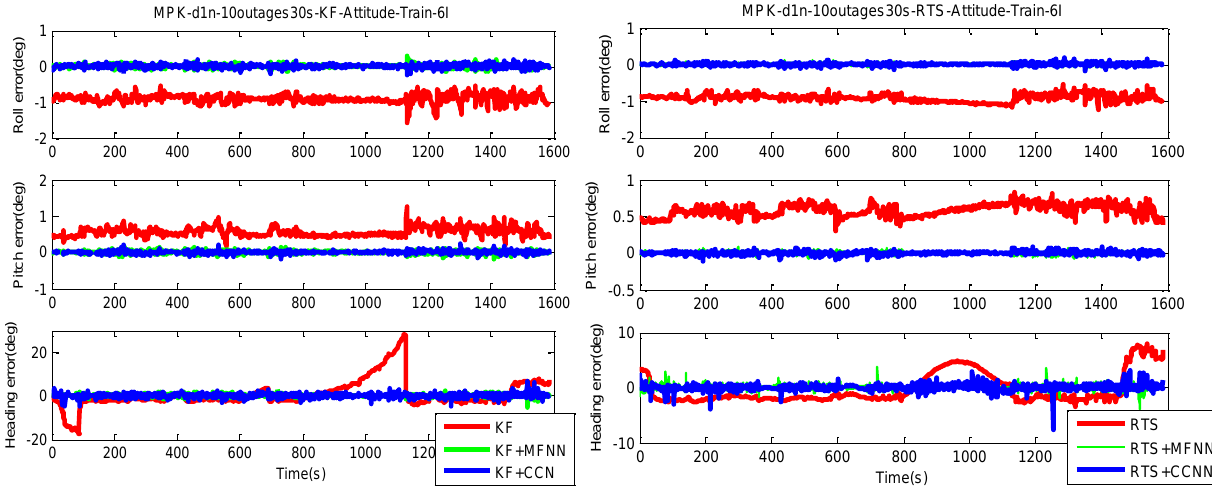
Figure 18 . The samples of compensated positional and orientation errors (Training